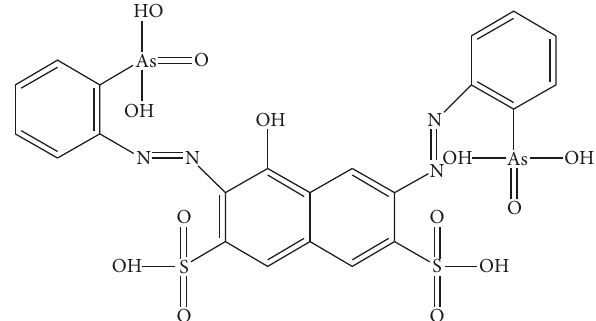
Figure 1: The chemical structure of arsenazo